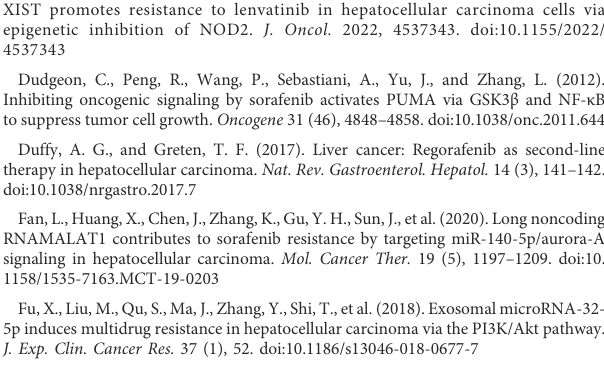
Tables 1, 2 have been added to the published article.